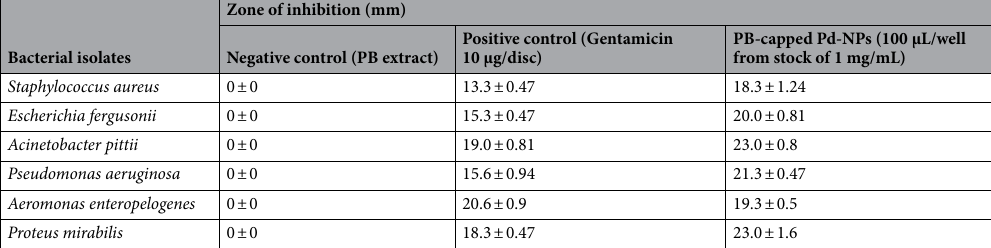
Table 4. Antibacterial activity of PB-capped Pd-NPs by well diffusion